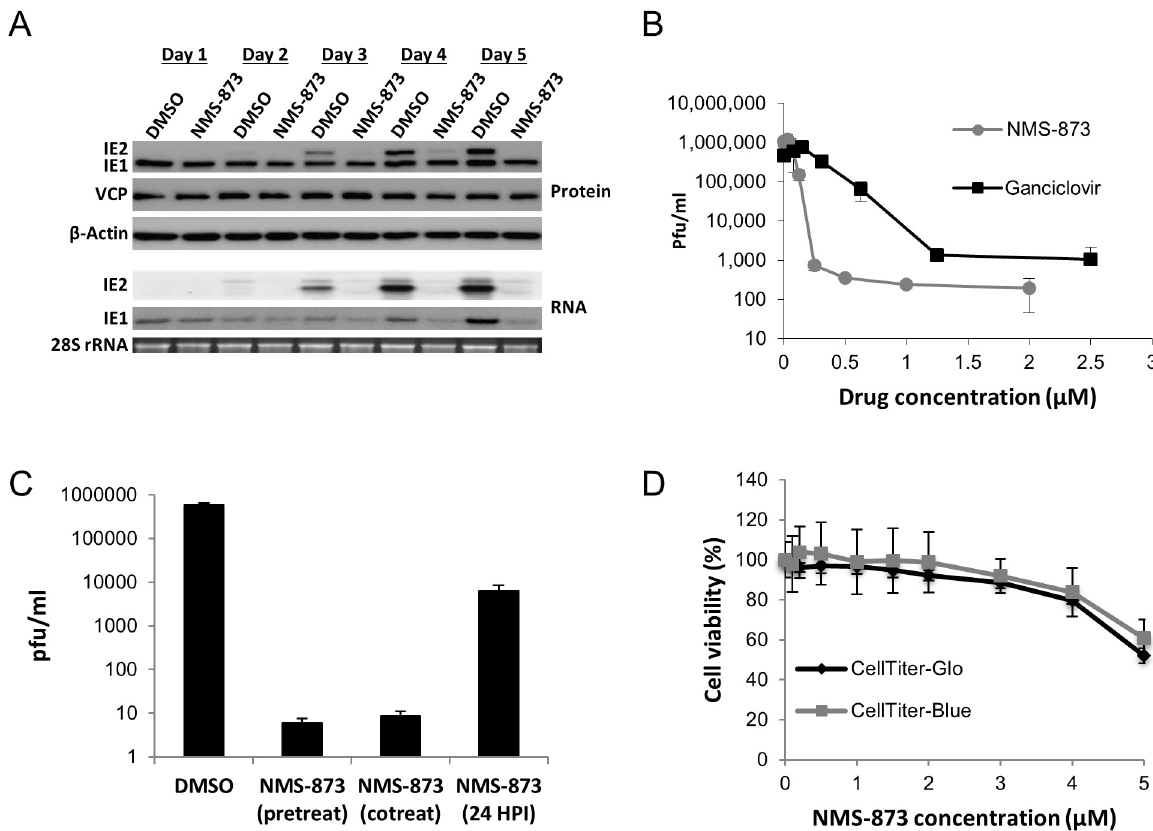
Fig 10. VCP inhibitor NMS-873is a potent HCMV antiviral. (A) Treatment with NMS-873causes the same phenotype as knockdown of VCP. Cells were pretreatedwith 1 μ M NMS-873then infected at high MOI with HCMV. Total RNA and protein were harvestedat the indicatedtimes and IE1 and IE2 protein and RNA levels measuredby Western and Northernblot analysis. (B) Cells were treated with the indicatedconcentrations of NMS-873or Ganciclovir then infected 24 hours post treatment. Cell and supernatant was harvestedat the indicatedtime points and virus levels determined by plaqueanalysis. (C) Cells were treated with NMS-87324 hours before infection, at the same time as infection, or 24 HPI. Supernatant was collectedseven days post infectionand virus titers determined by plaqueassay. (D) Cell viabilitywas determinedfive days post treatment at the indicatedconcentrations of NMS-873 using two independentcommercialkits, Cell Titer-Glo and Cell Titer-Blue. (B-D) Data represents two biologicalrepeats.